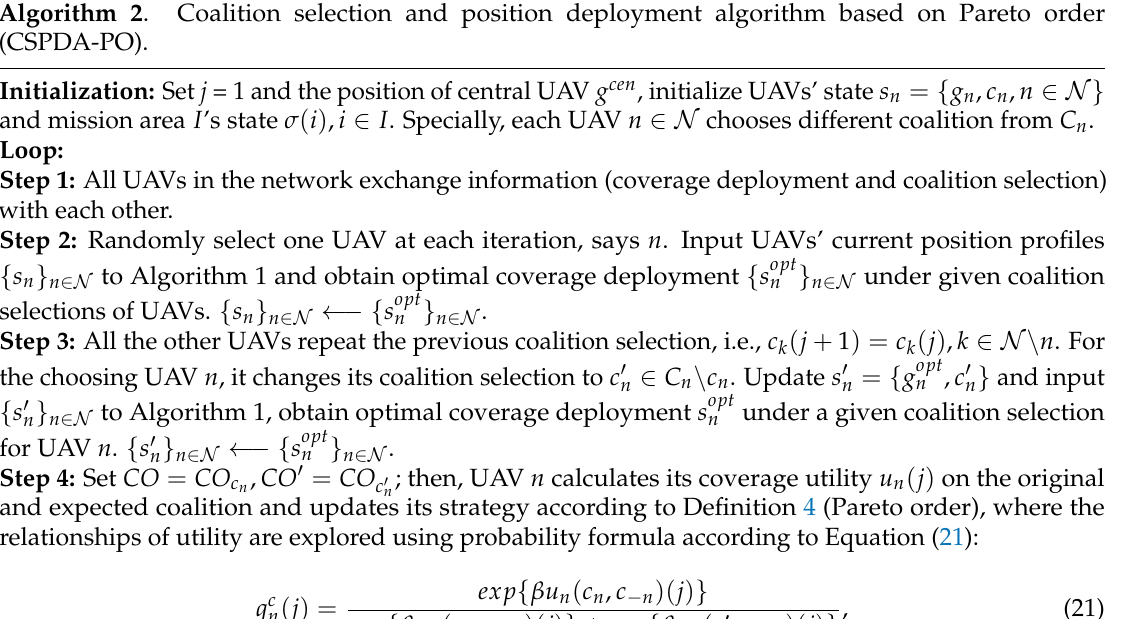
Algorithm 2 . Coalition selection and position deployment algorithm based on Pareto